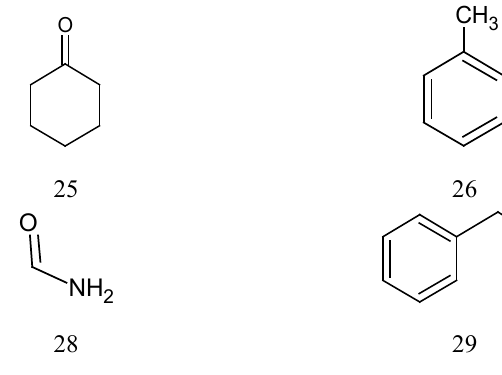
Figure 1. The structures of 29 organic solvents for single-walled carbon nanotube (SWCNT)